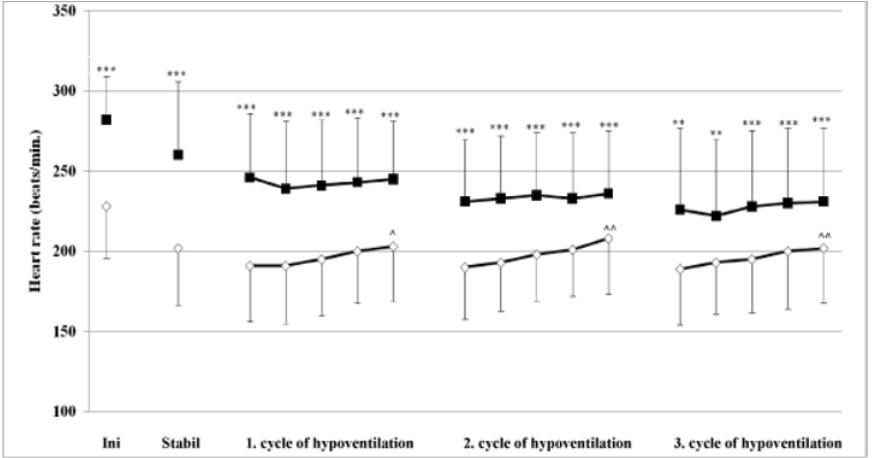
Figure 2. The asphyxic average heart rate (HR) values ± SD during preconditioning in the light (empty rhombus) and in the dark (black square) part of the day. Ini – intact animals; Stabil – after stabilization. *** p < 0,001; ** p < 0,01 statistically significant differences between HRs measured during the light and dark part of the day. ^ p < 0,05; ^^ p < 0,01 statistically significant HR difference between the 1-minute and 5-minute cycles of